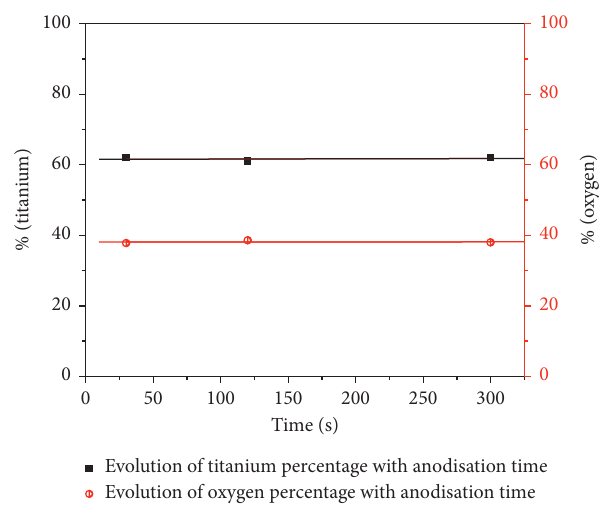
Figure 2: Amounts of titanium and oxygen at fixed polarization voltage (25 V) at various